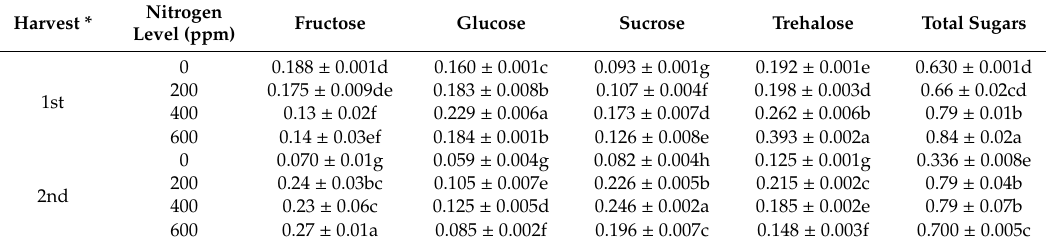
Table 4. Composition in sugar (g / 100 g fw) of Centaurea raphanina v mixta plants grown in 2 L pots under greenhouse conditions, in relation to harvesting time (1st and 2nd harvest) and nitrogen level (0–600 ppm) (mean ± SD; n =